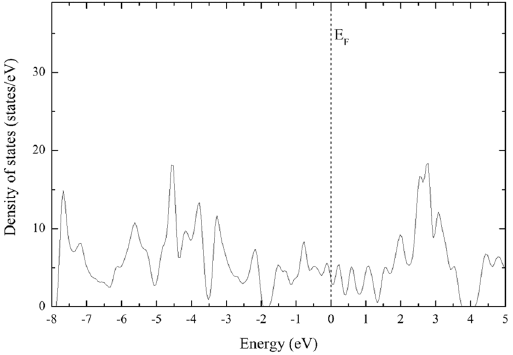
Figure 6. ReCN monolayer density of states. The reference energy was set at the Fermi